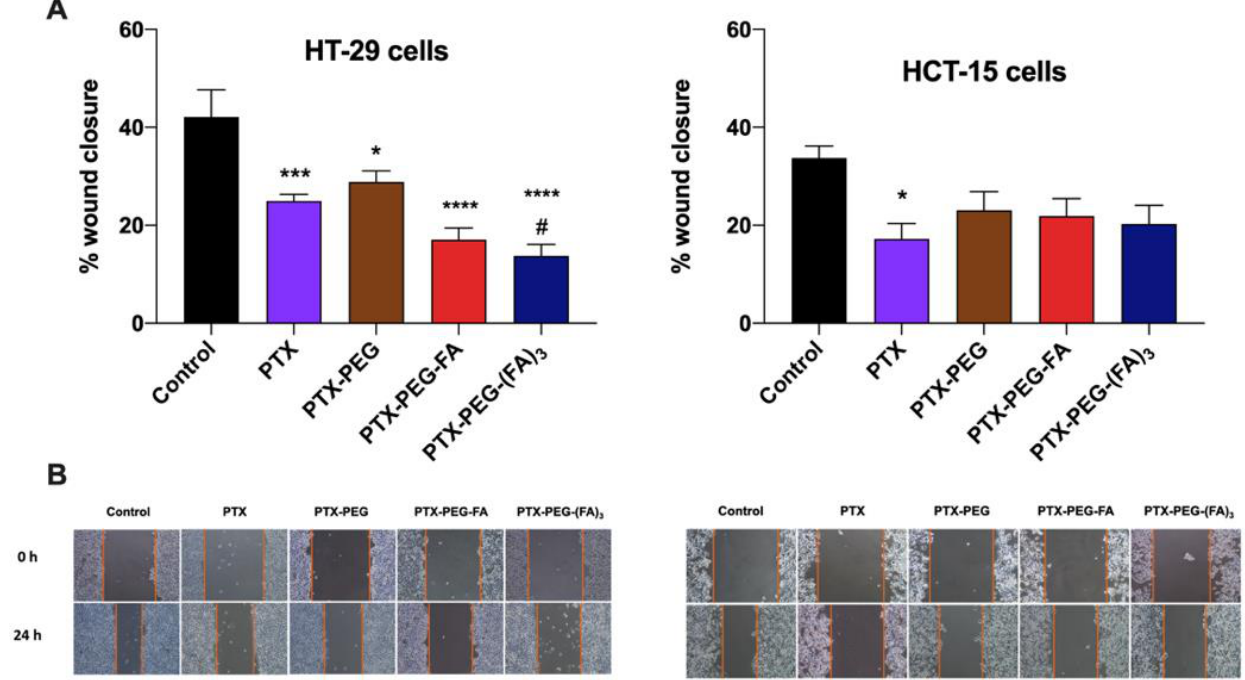
Figure 6. Wound healing assay in the CRC cell lines HT-29 and HCT-15. ( A ) Quantitative analysis of scratch wound healing assay after a 24 h treatment with NEM or CP (half IC 50 /48 h). ( B ) Representative images of the scratch wound healing (magnification 10×). The results are the mean of three independent experiments. * p < 0.05, *** p < 0.001, **** p < 0.0001 vs. untreated control cells; # p < 0.05 vs. cells treated with PTX.